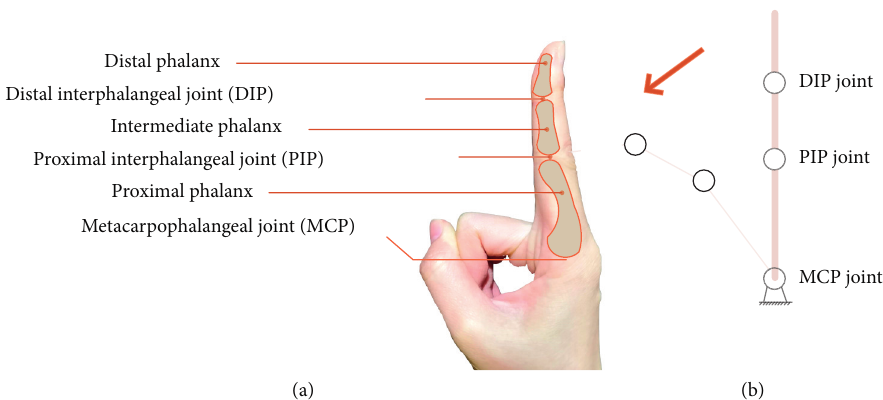
Figure 1: Theoretical model. (a) Names of different finger joints. (b) Simplified